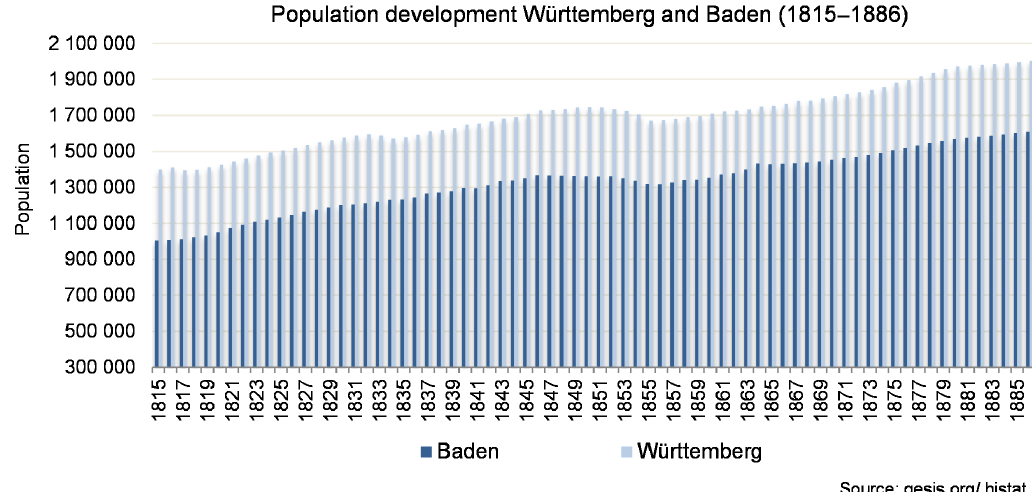
Figure 3. Population development in Baden and Württemberg